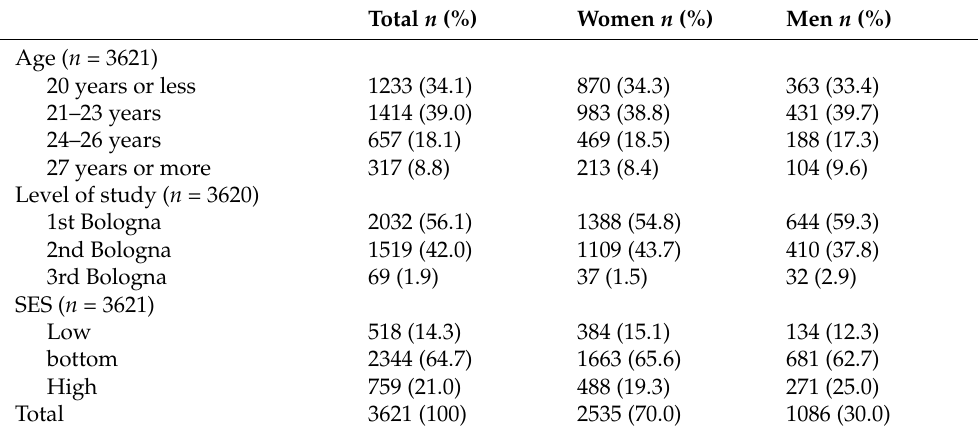
Table 1. Socio-demographic characteristics of the study